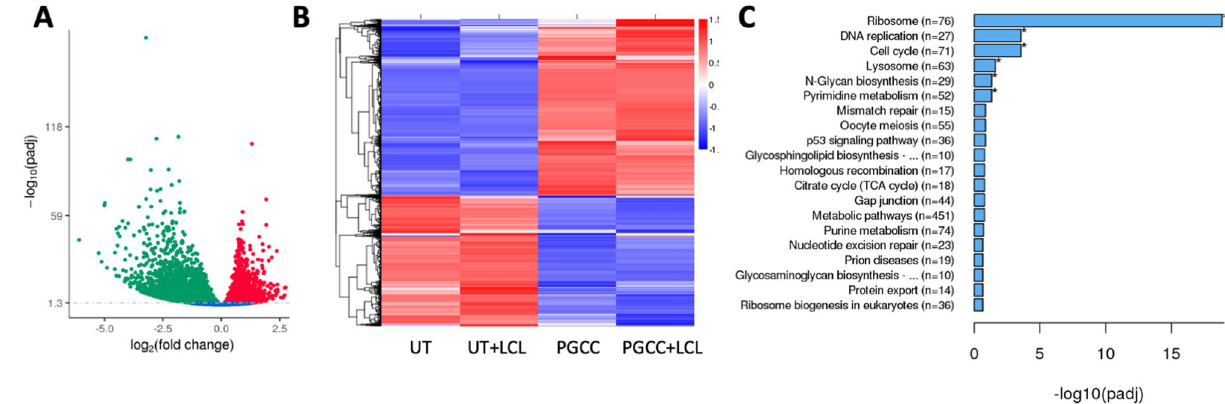
Figure 2. Transcriptomics-identified differences between parental PPC1 cells and PGCC generated through radiation. ( A ) Volcano plot and ( B ) heat map of differentially expressed genes between untreated parental cells (UT) and PGCC ( C ) Top 20 KEGG bioinformatics groups altered in PGCC. Analysis was performed by Novogene using the DESeq2 R package (v.2_1.6.3).